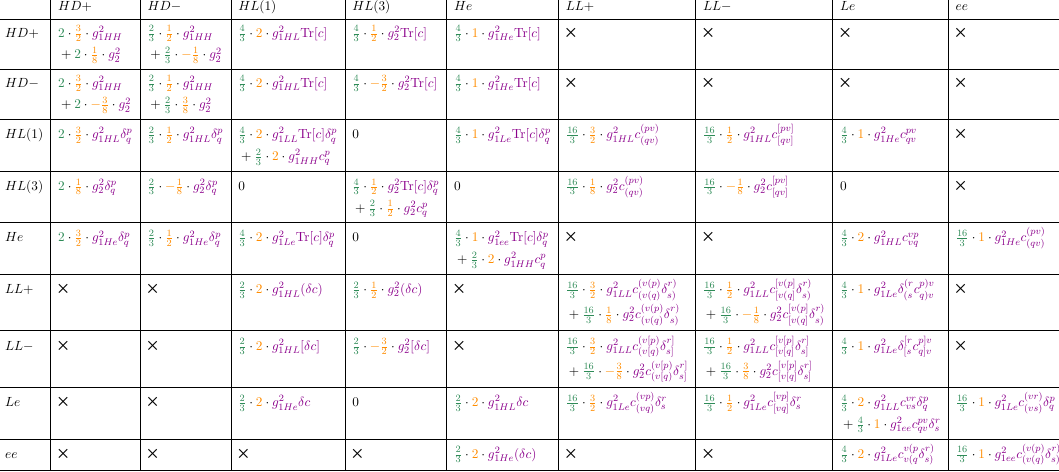
Table 5 . IR finite gauge pieces of the (4 , 0) block of the colourless SMEFT anomalous dimension matrix. g 2 = g 2 y X y Y includes the product of the hypercharges of the two species. Operators are 1 1 XY defined in table 11. Phase space factors, in green, can be found in appendix E.1 and are explained in section 3.1.1. Gauge factors, in orange, can be found in tables 2, 13 and 14, and are explained in section 3.2. The flavour factors, in purple, labelled by p, q, r, s indices, can be found in table 3, and are explained in section 3.3.